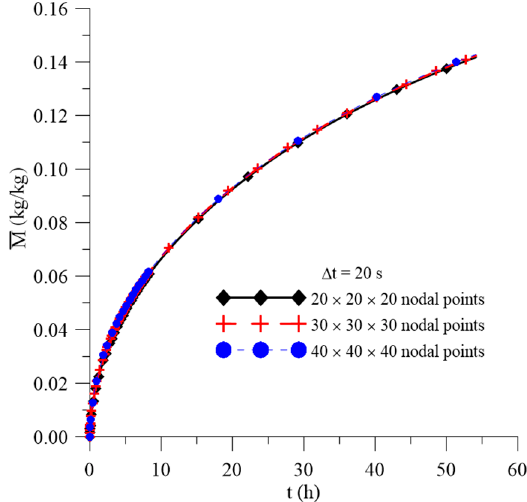
Figure 8. Transient behavior of the average moisture content for different meshes.